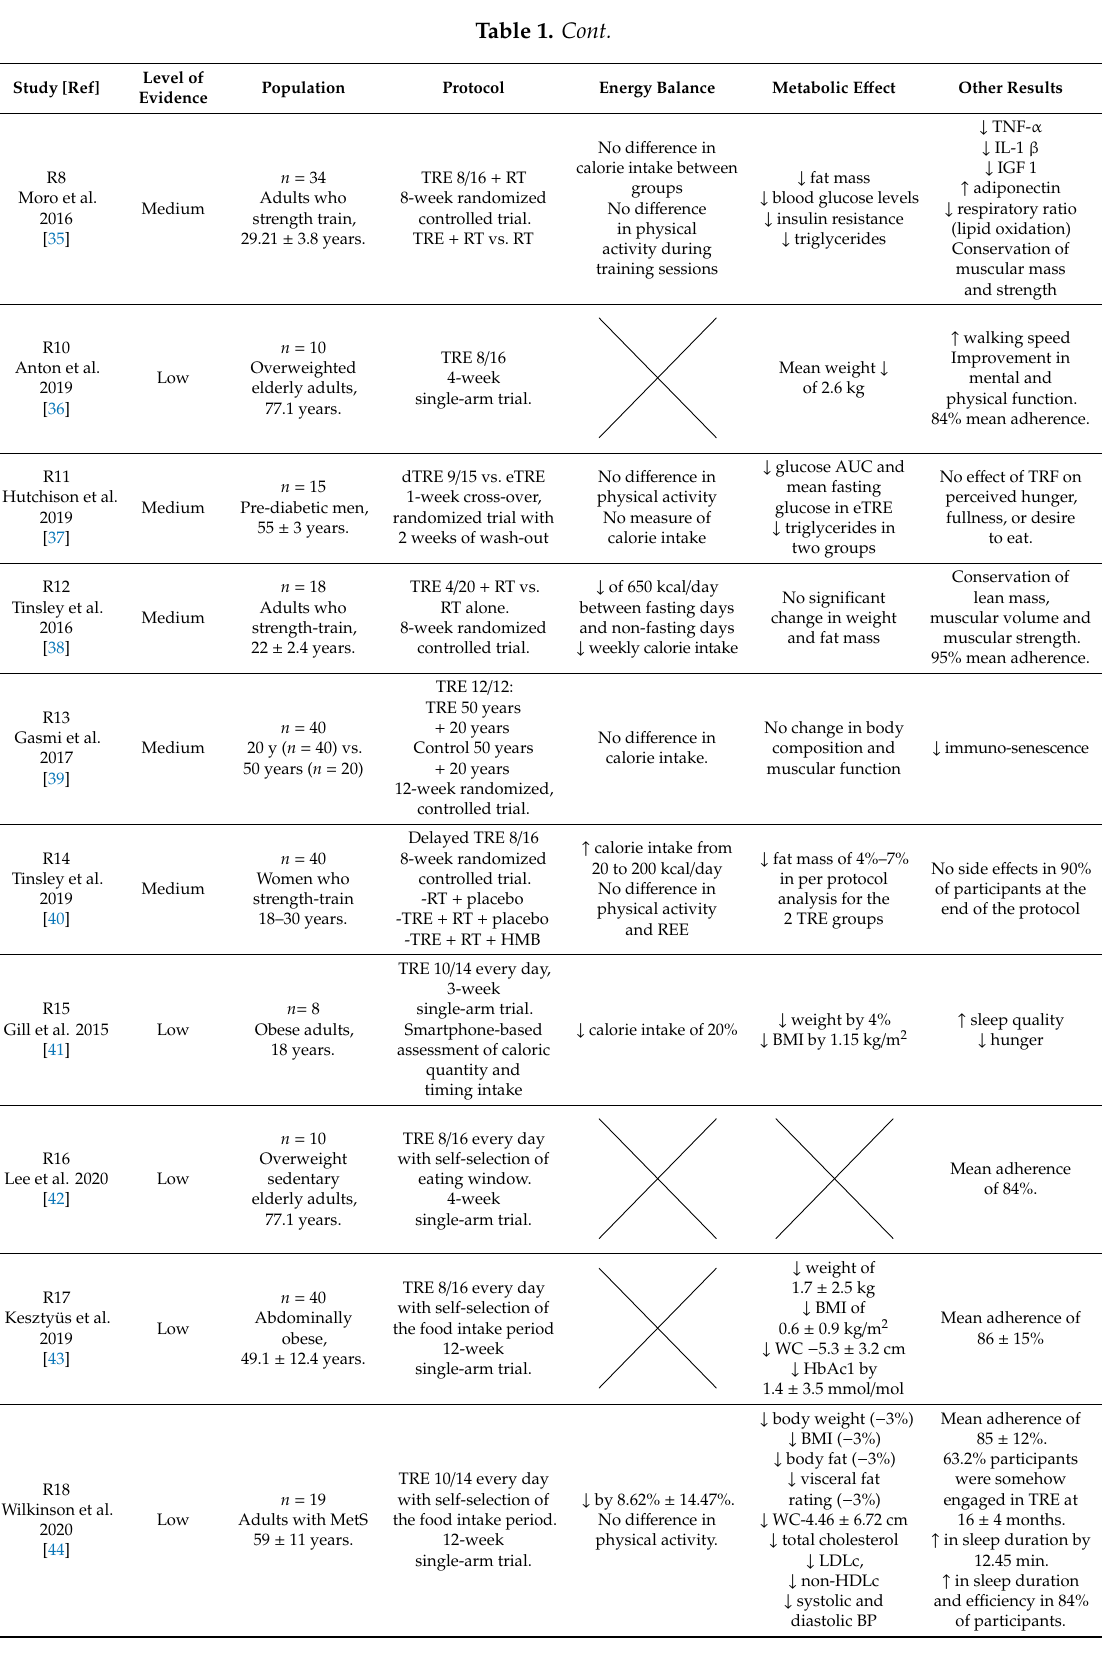
Table 1. Synthesis of